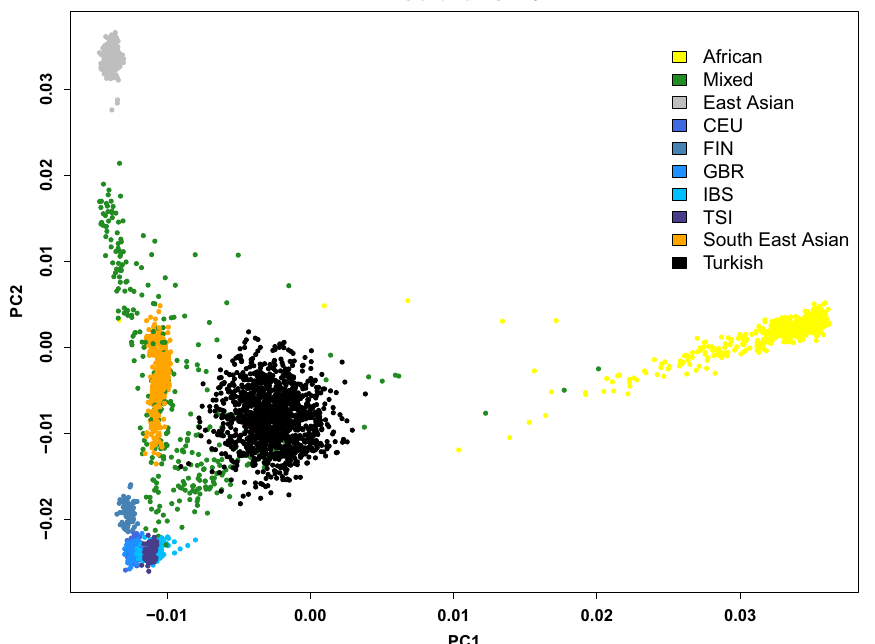
Figure 2. Continental principal component analysis (PCA) of the Turkish samples (black color) projected on the 1000 Genomes Phase 3 data shows that Turkish samples cluster closely together as a mixed population. PC1 on the X-axis and PC2 on the Y-axis. Each color represents one of the ancestral groups. Abbreviations: CEU, Northern Europeans in Utah; FIN, Finnish in Finland; GBR, British in England and Scotland; IBS, Iberian populations in Spain; TSI, Tuscans in